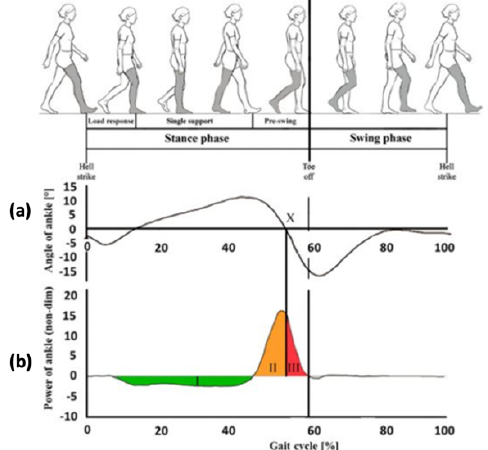
Figure 1. ( a ) Diagram of the ankle angle in the gait of a healthy individual and ( b ), corresponding diagram of the power of the ankle, rendered dimensionless. I is the area with negative power, starting from the heel strike; II is an amount of the area with positive power corresponding to the thrust phase; III is the remaining amount of the area with positive power, corresponding at the final stage of the stance phase in a healthy individual; X is the point in which the foot loses contact with the ground, in the case of a user with an ESR